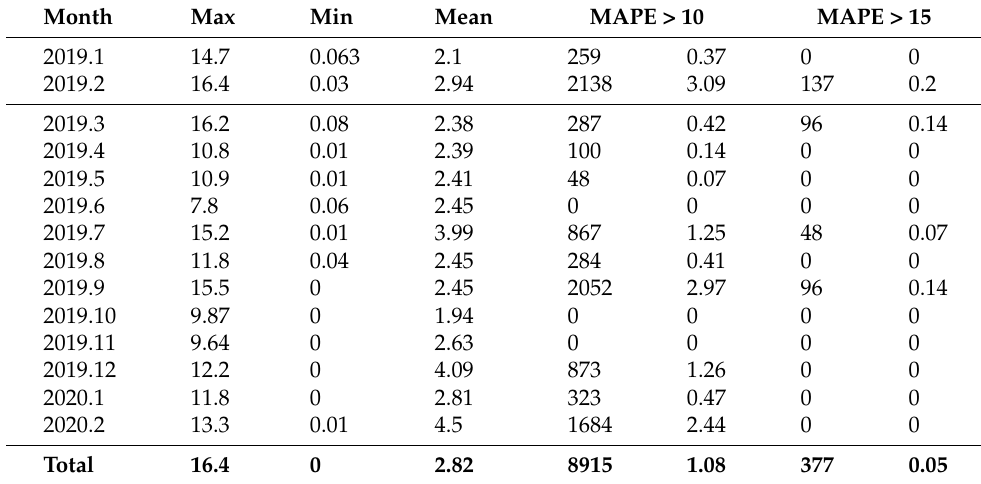
Table 3. Monthly error for test